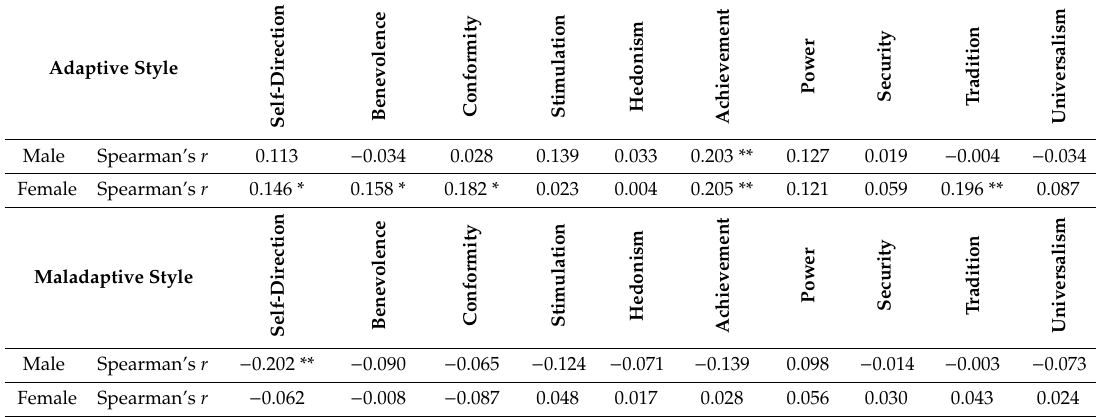
Table 3. Correlation between decision-making styles and value categories based on